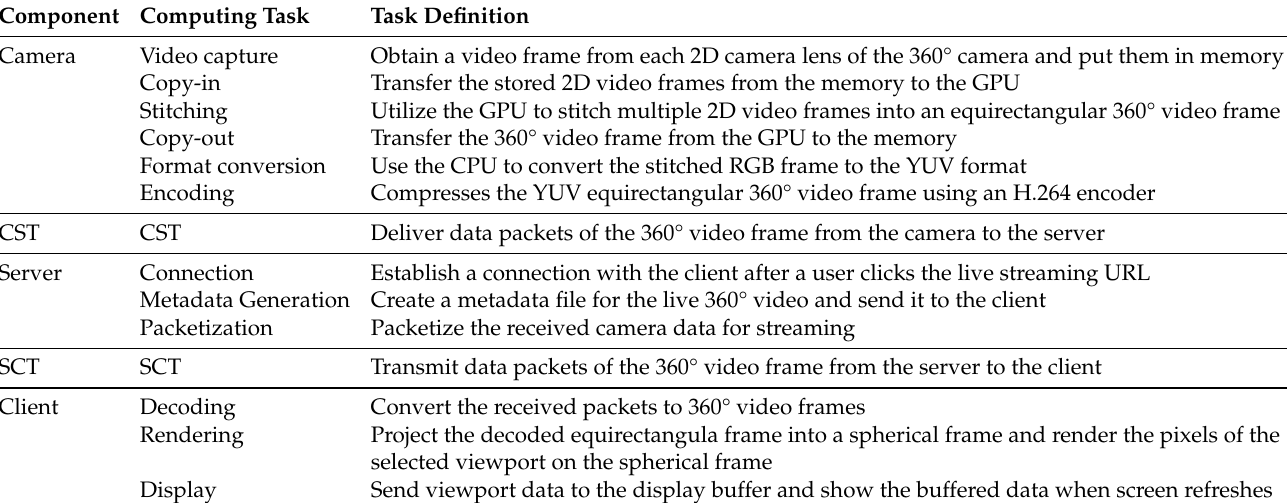
Table 1. System components and computing tasks in 360° video camera